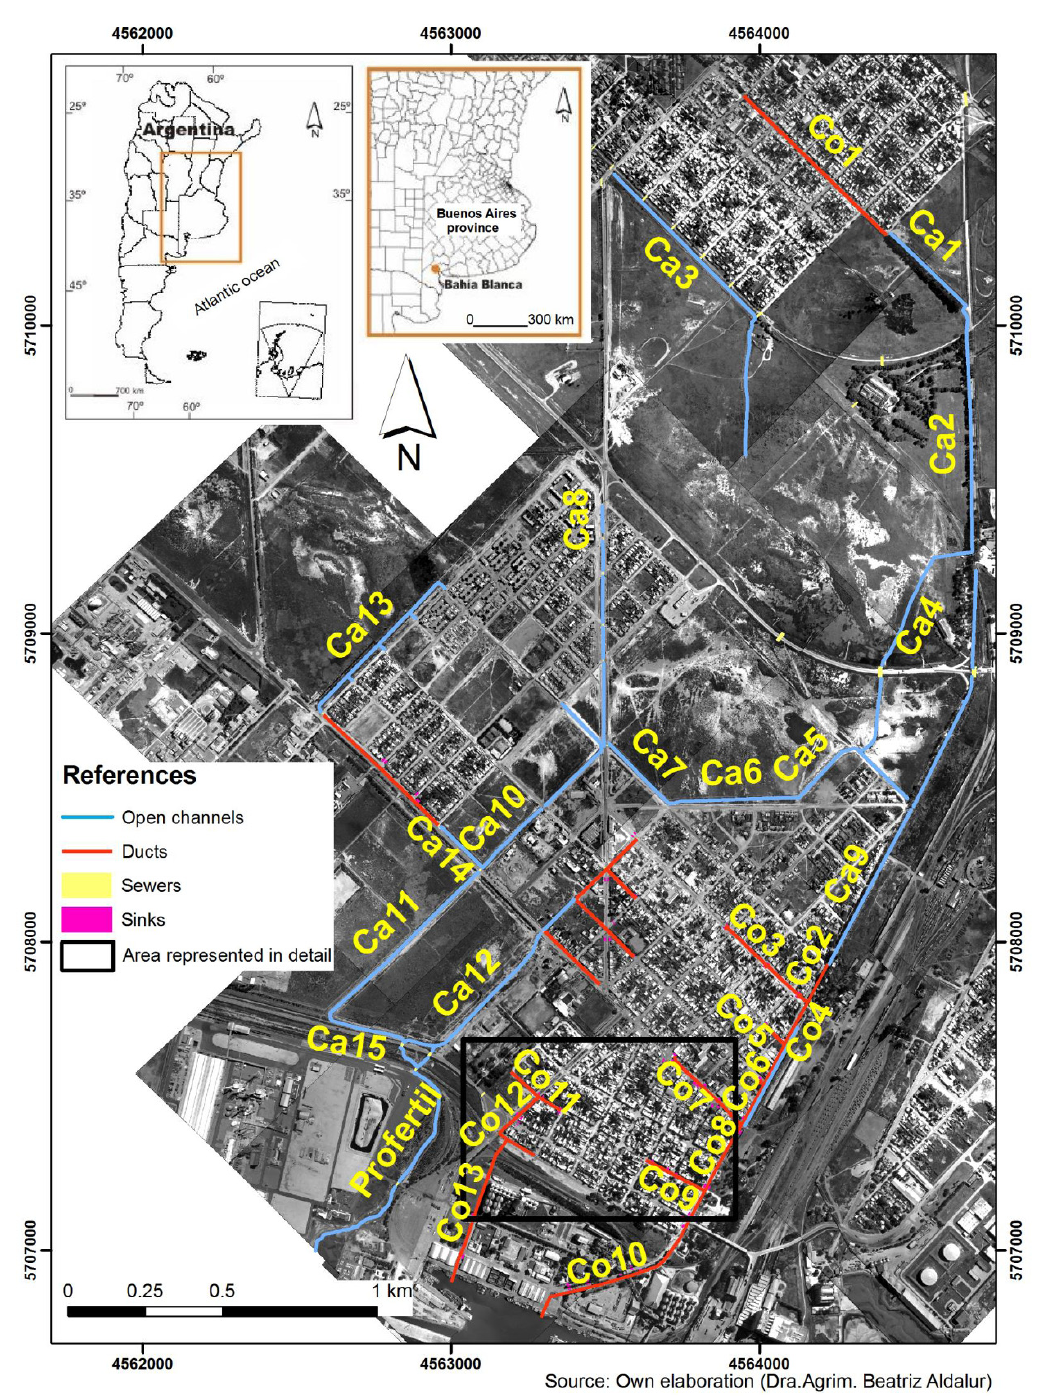
Figure 3. Location of storm water pipes, open channels, sinks and